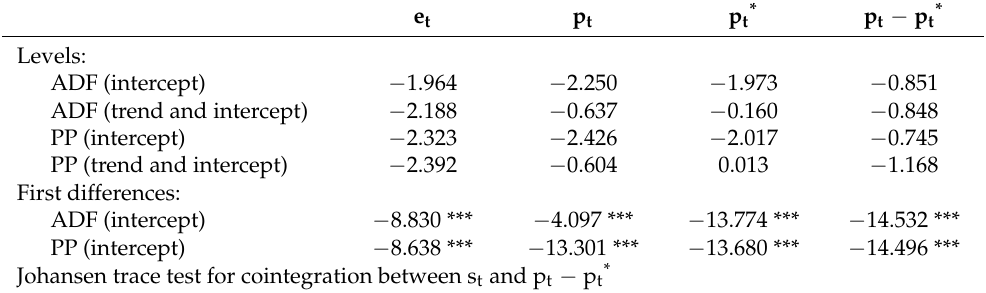
Table 1. Standard unit root